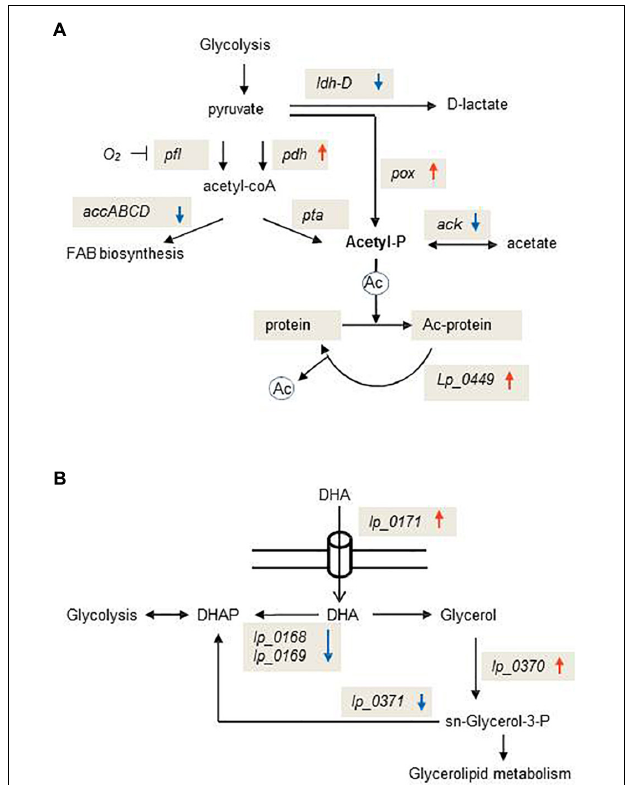
FIGURE 3 | Schematic representation of exemplary metabolic pathways transcriptionally affected by oleuropein in Lactobacillus plantarum WCFS1. (A) Schematic diagram of the pathway for glycolytic production of acetyl-P and post-translational modifications in which this metabolite is involved. (B) Schematic diagram of the pathway for the production of the glycerolipid precursor, sn-glycerol-3-P. PDHc, pyruvate dehydrogenase complex; PFL, pyruvate formate lyase; AccABCD, acetyl-CoA carboxylase; LDH-D, D -lactate dehydrogenase; POX, pyruvate oxidase; ACK, acetate kinase; PTA, phospho-transacetylase. Ac-protein, acetylated protein. DHA, dihydroxyacetone; DHAP, dihydroxyacetone-phosphate. Upward red arrows indicate up-regulated genes; downward blue arrows indicate down-regulated